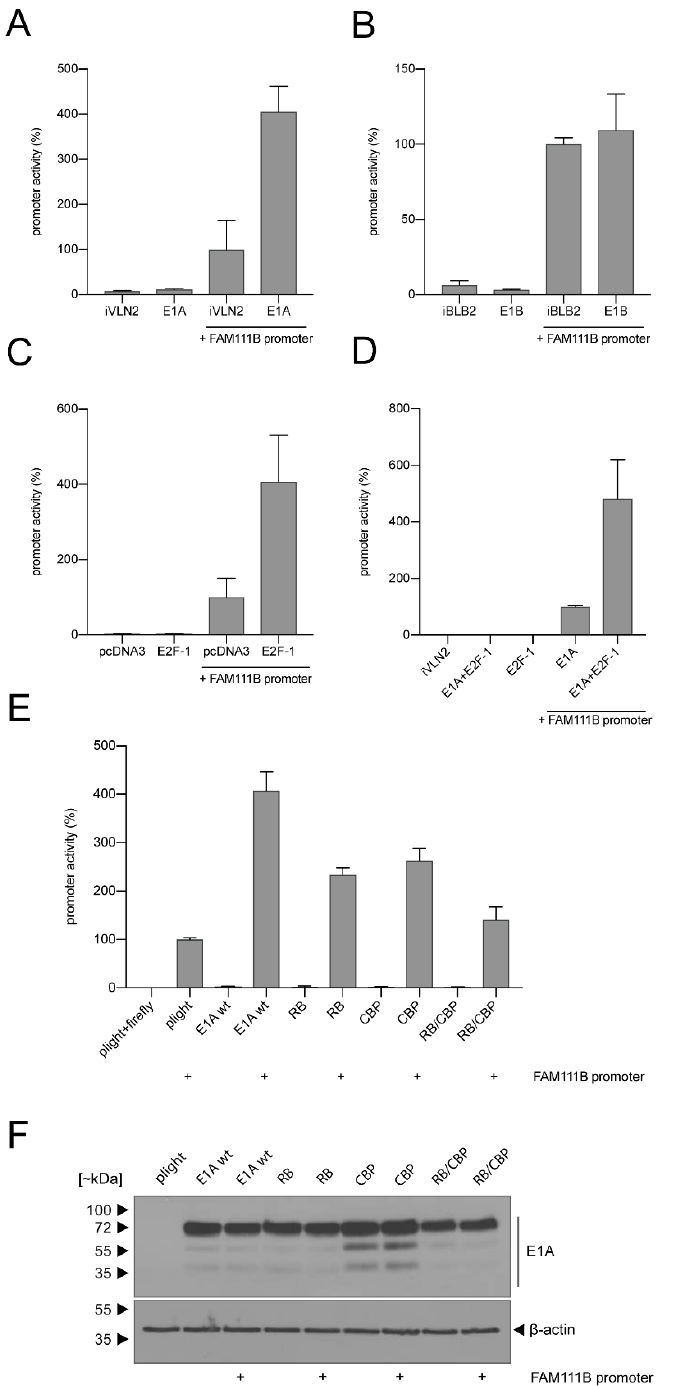
Figure 3. E1A activates FAM111B transcription that is enhanced by E2F-1 and depends on its RB/CBP motif. H1299 cells were transfected with 0.5 µ g of pFirefly-TK, 0.5 µ g of FAM111B promoter. ( A ) LeGO-iVLN2 E1A, ( B ) LeGO-iBLB2 E1B-55K, ( C ) E2F-1, ( D ) LeGO-iVLN2 E1A and E2F-1, (E) LeGO-iVLN2 wt E1A, RB, CBP single- or RB/CBP double-binding mutants. (F) Input levels of total